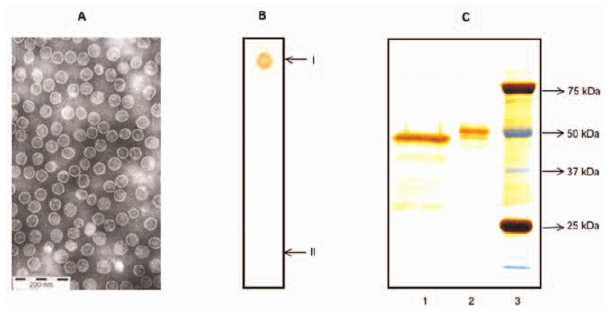
Figure 1. Characterization of antigens. EM of sterile TSV particles (A) purified by caesium chloride density gradient ultracentrifugation, with 200 nm scale bar shown. Dot blotting (B) for TSV antigen, studied with TSV-IgG positive (I) and negative (II) sera. Silver staining of capsid proteins (C) in 10% SDS PAGE. Lane 1: TSV VP1 capsid antigen, lane 2: MCV VP1 capsid antigen, lane 3: molecular weight